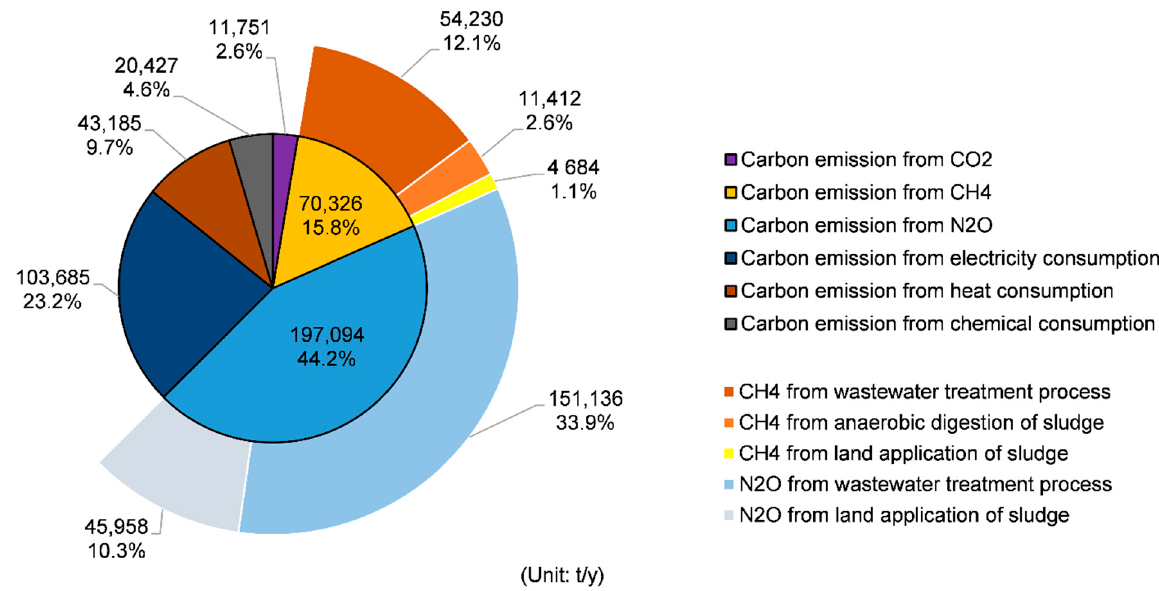
Figure 3. The composition of carbon emission from Gaobeidian WWTP.